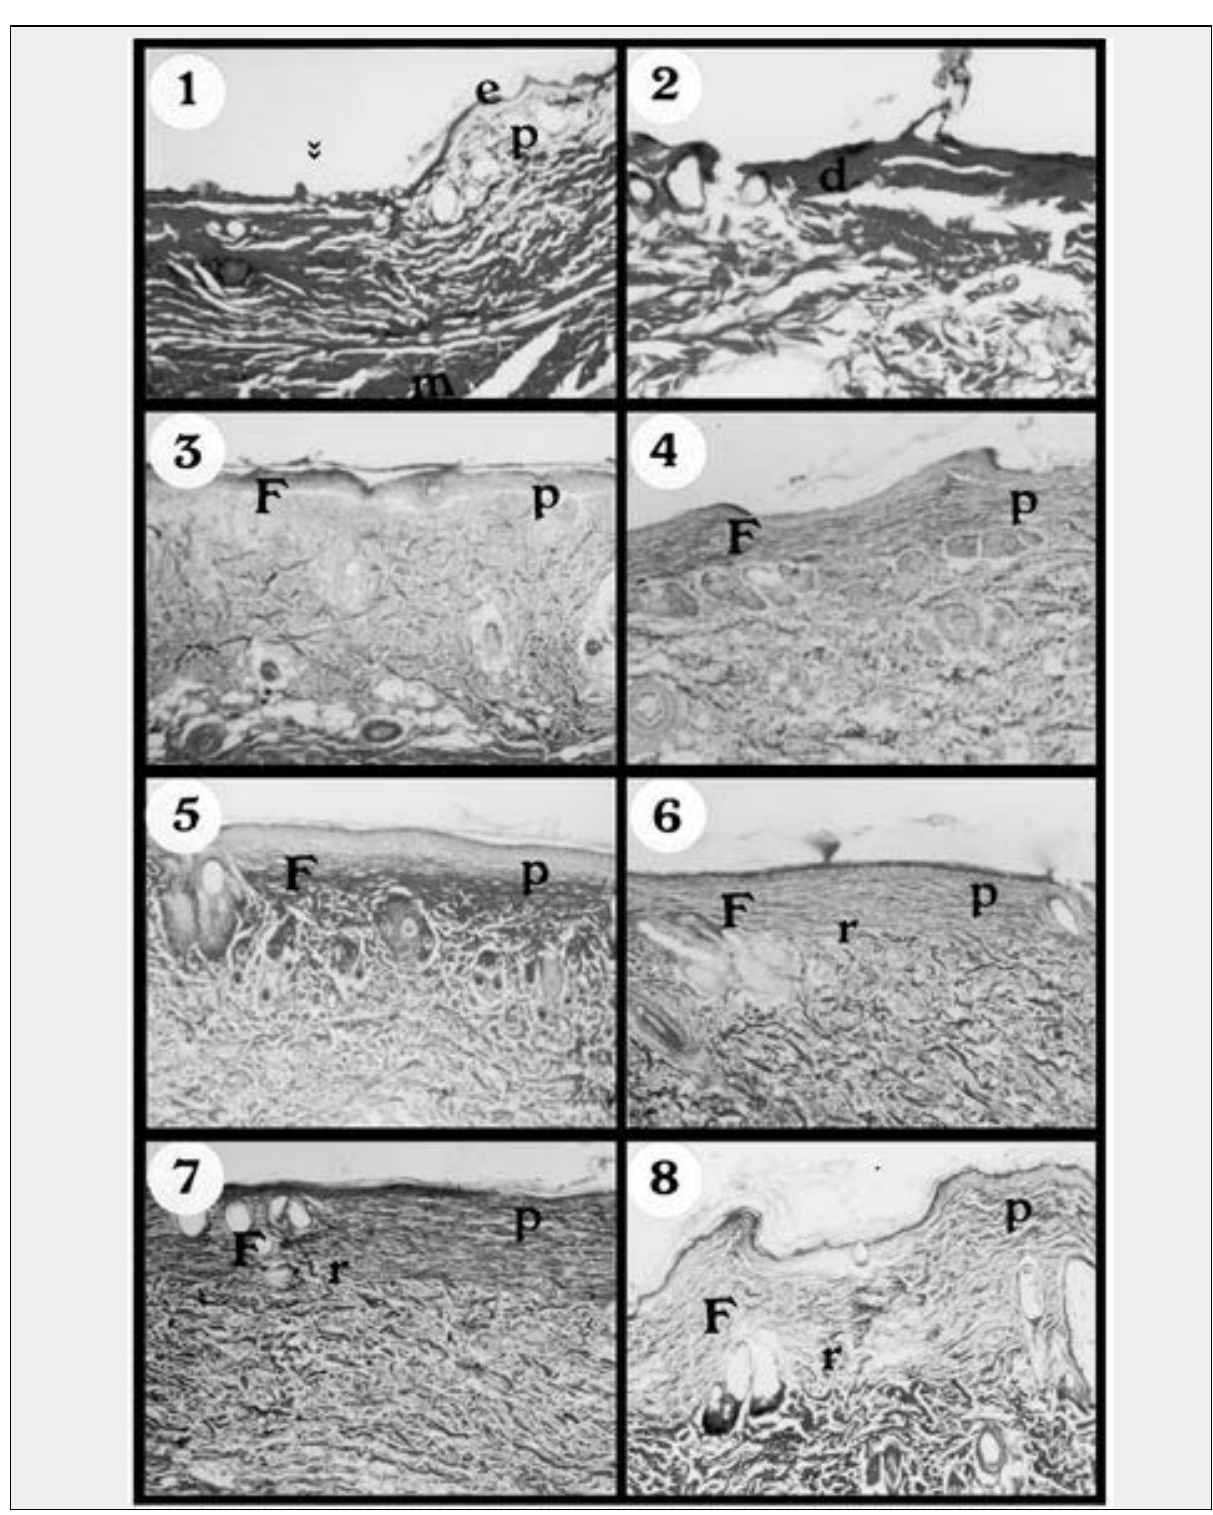
--- As Figuras 1 e 2 foram retiradas de animais do grupo G1, sacrifício no dia 0. As Figuras 3 a 8 foram retiradas de animais dos grupos G2, G3, G4, G5, G6 e G7, respectivamente, compreendendo os dias 7, 14, 28, 56 e 84 de sacrifício. As Figuras 1, 3, 4, 5, 6, 7 e 8 foram capturadas com aumento de 100x. Somente a Figura 2, que é um detalhe da 1, foi capturada com aumento de 400x. As Figuras 1, 2, 4 e 5 estão coradas pela elástica de Weigert e as Figuras de números 3, 6, 7 e 8 pelo tricrômico de Mallory (e = epiderme, p = derme papilar, r = derme reticular, m = músculo estriado esquelético dorsal, d = DTR, F = .broplasia e >> = DA). Na Figura 1 observa-se dano de ablação (>>) que é representado pela ausência completa da epiderme (e) e da derme papilar (p) quando se compara com a porção não-lesada da pele. Na Figura 2 (detalhe da Figura 1) observa-se o dano térmico residual (d) representado por faixa de tecido compacto e homogêneo em vermoelho-escuro. As Figuras 3 a 8 devem ser analisadas comparativamente onde a fibroplasia (F) representada por faixa colágena vai progressivamente aumentando. Observe que na Figura 3 a fibroplasia compromete apenas a derme papilar (p). Já nas Figuras 4 e 5 a fibroplasia (F) compromete derme papilar (p) e porções superficiais da derme reticular (r). Se analisarmos as Figuras 6, 7 e 8, observamos que a fibroplasia (F) atinge a derme papilar (p) e toda a porção superficial da derme reticular (r), indo até a derme reticular média na Figura